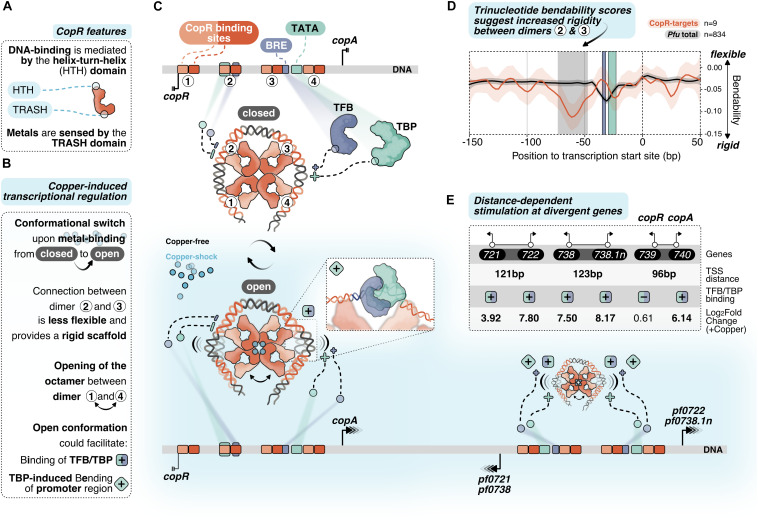
Putative model of allosteric CopR regulation in P. furiosus.
(A) Domain architecture of CopR (monomer shown schematically in red) highlighting the DNA-binding HTH domain and the metal-sensing TRASH domain. (B) Binding of copper presumably triggers a conformational switch from a closed state to a complex, which is opened between dimer 1 and 4. In combination with the rigid connection between dimers 2 and 3 it is possible that this conformational switch could facilitate TBP/TFB binding (+ square) and/or TBP-induced bending to the corresponding promoter regions (+ turned square). (C) CopR-regulated promoter regions include CopR-binding sites (orange/red) and the archaeal-specific promoter elements BRE (recruits TFB, purple) and the TATA box (bound by TBP, light-green). Transcription start sites (TSS) are indicated by vertical lines. Transcription is either repressed (3 lines) or stimulated (arrows) under copper-shock conditions (lower panel, light-blue). The octameric CopR assembly in open conformation allows bending of critical promoter regions and facilitates binding of TBP/TFB depending on the distance of the divergent TSS: While CopR prevents binding of general transcription factors to the copR promoter, TBP/TFB can bind to the second promoter (copA). Simultaneous binding of CopR and two sets of GTFs stimulates transcription in both directions for pf0722/pf0271 and pf0738/pf0738.1n. (D) Major groove bendability of selected promoters revealed increased rigidity between dimers 2 and 3. Major groove bendability of promoter sequences was estimated based on trinucleotide scales derived from DNase-I cutting frequencies (Brukner et al., 1995; Meysman et al., 2014). More negative values are the result of less cutting by DNase-I and indicate that the DNA is not bend towards the major groove and is therefore less flexible. Trinucleotides were extracted from CopR-target promoters (n = 9) and all available promoters defined in P. furiosus previously (Grünberger et al., 2019) from –150 bp to +50 from the TSS. Each line represents the smoothed conditional mean with confidence intervals (0.95) displayed as shaded areas. Boxes represent area between dimers 2 and 3 (gray), BRE (purple) and TATA box (light-green). (E) Summary of the TSS-distance dependent stimulation of divergent CopR-regulated transcripts.